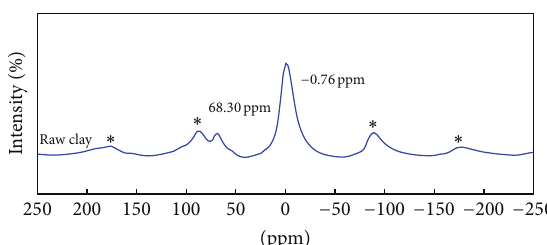
Figure 1: Solid state 27 Al MAS NMR of raw clay. ∗ Noise made during